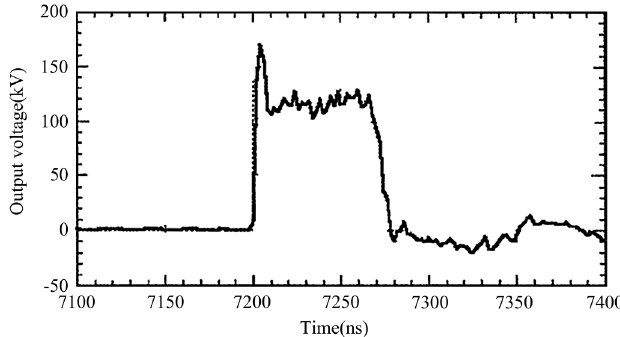
calculation.FIG. 7. Typical output voltage of the IEBA-B during the experiment in Ref.